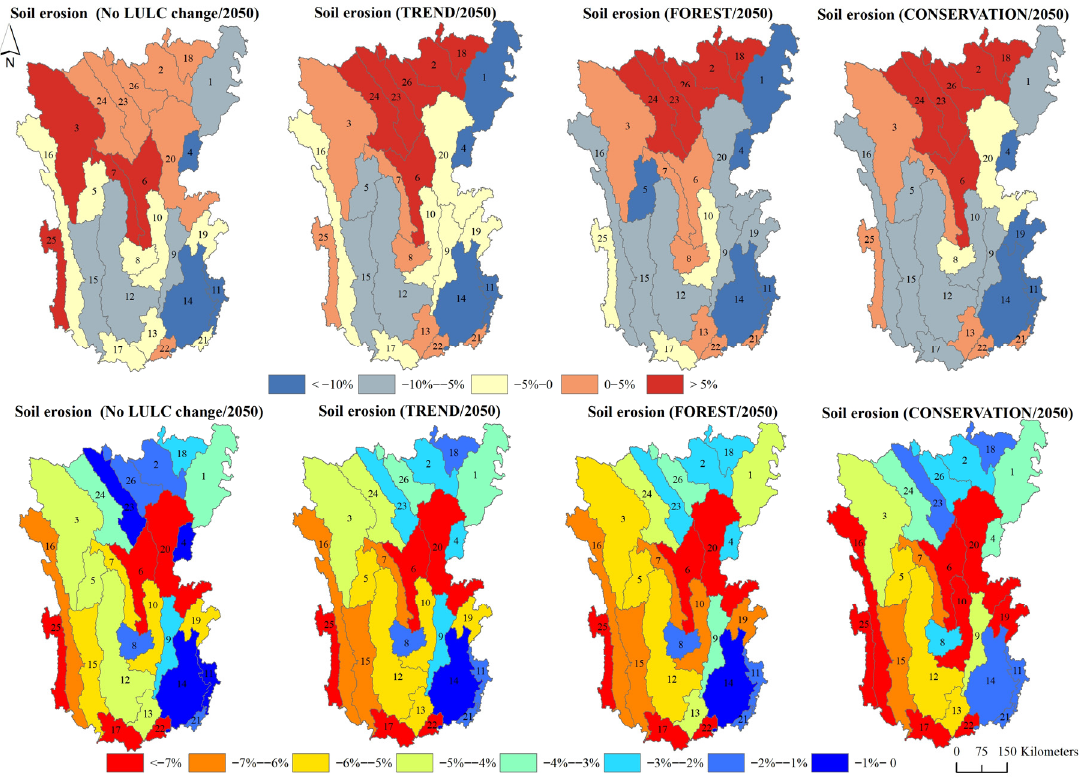
Figure 9. Change rate of soil erosion and water yield in the sub-watersheds under different scenarios (2050) when compared with 2020.